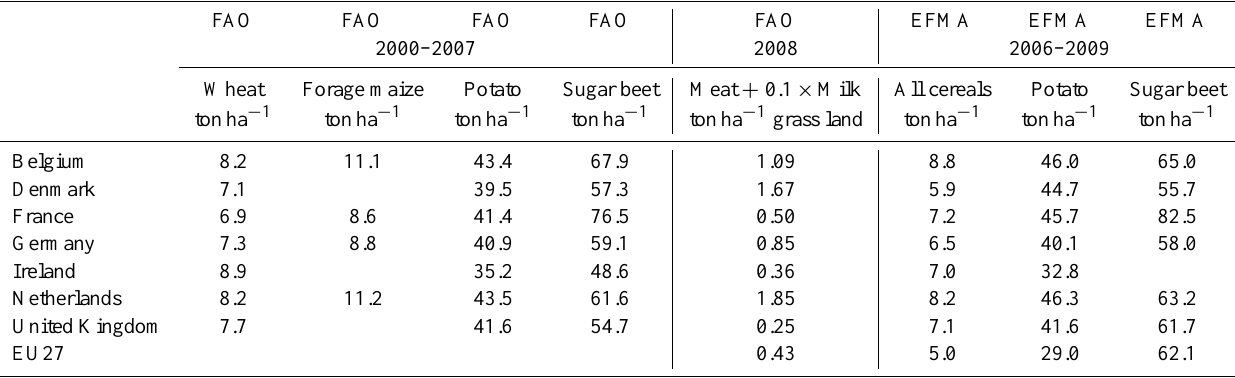
Table 3. Mean annual yields in northwestern member states of the EU for cereals, forage maize, potato and sugar beet (Sources: FAOSTAT mean crop data are for the period 2000–2007; EFMA (2008), mean data for 2006–2009), and the sum of ruminant meat + 0.1 × total milk production as a proxy for ruminant productivity per hectare of permanent grassland (Sources: production from FAOSTAT, data 2008, and grassland areas from Eurostat (2011), data 2007).